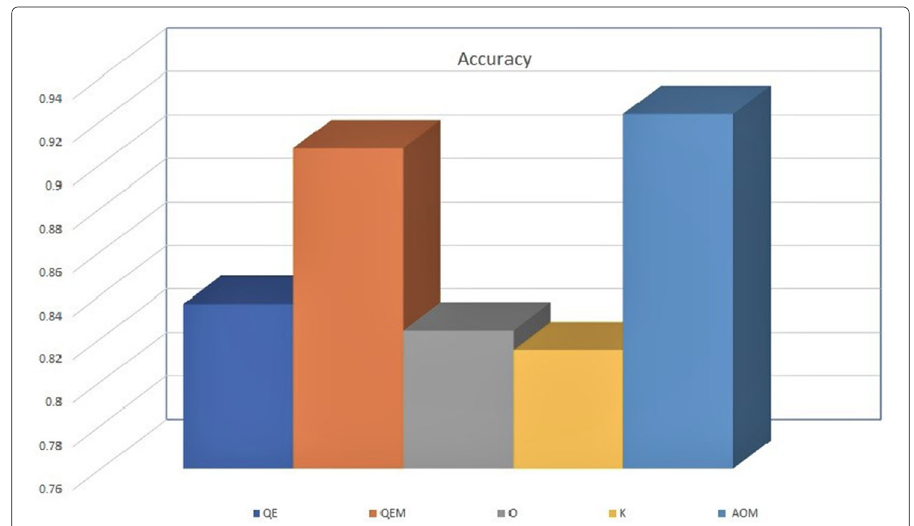
Fig. 11 This figure represents the average of accuracy for quantum entropy, modified quantum entropy (proposed), Otsu, Kapur method, and the hybrid of the proposed and Otsu,